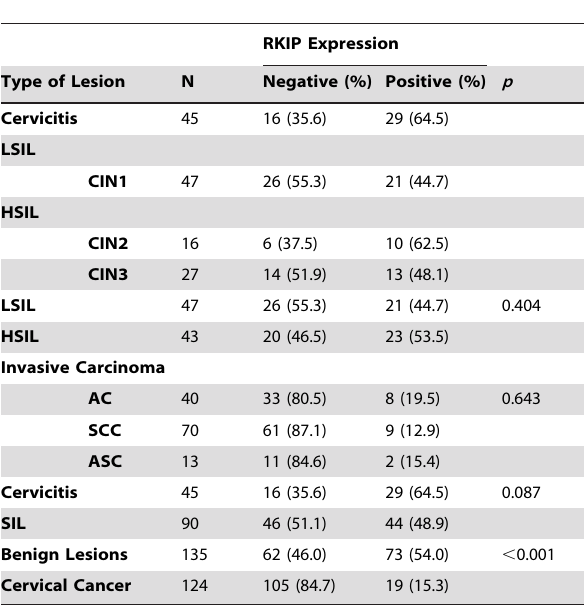
Table 1. RKIP expression in cervical lesions.